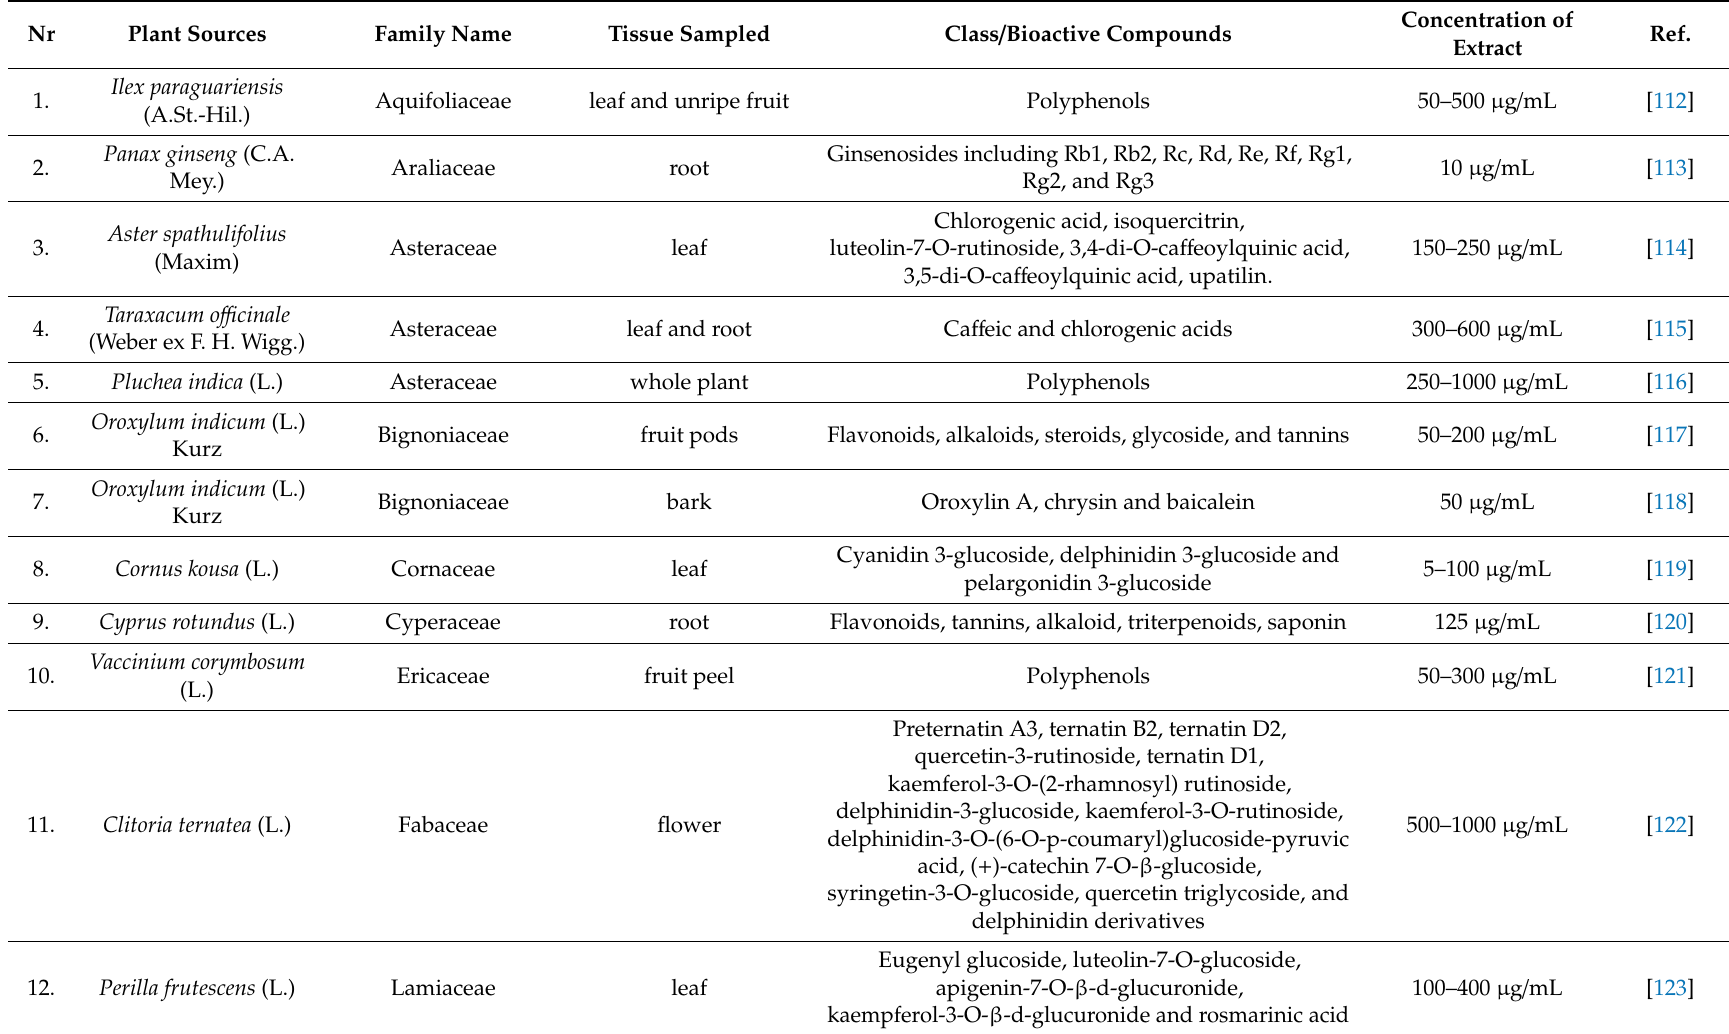
Table 1. Selected plant extracts with anti-obesity properties with characteristic chemical profiles, as confirmed in in vitro 3T3-L1